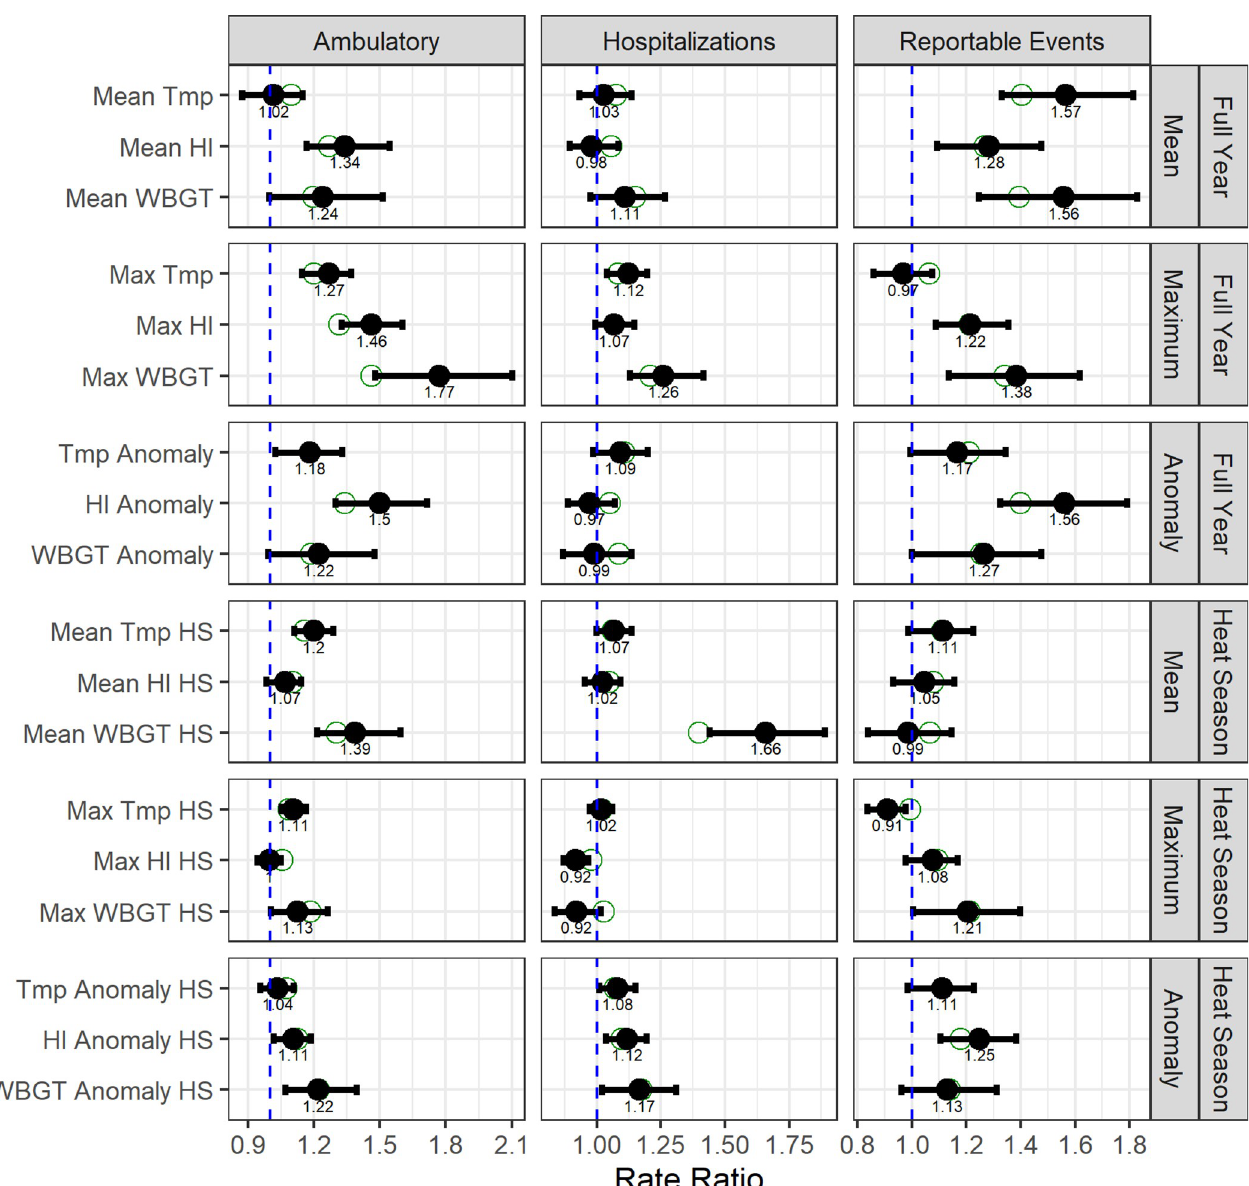
Fig 4. Rate ratios for full-year and heat season indices of heat and HSI encounters at 10 CONUS U.S. Army installations. RRs per 1 degree increase in annual index of heat (mean of daily means) from 2-year block bootstrap negative binomial models with basic (empirical) confidence intervals based on 2,000 replicates, controlling for installation-level effects. Solid points reflect the mean of bootstrap estimates and unfilled points reflect the original sample (non- bootstrap) estimate. The dashed blue vertical lines depict a RR of 1.0, indicative of no increased